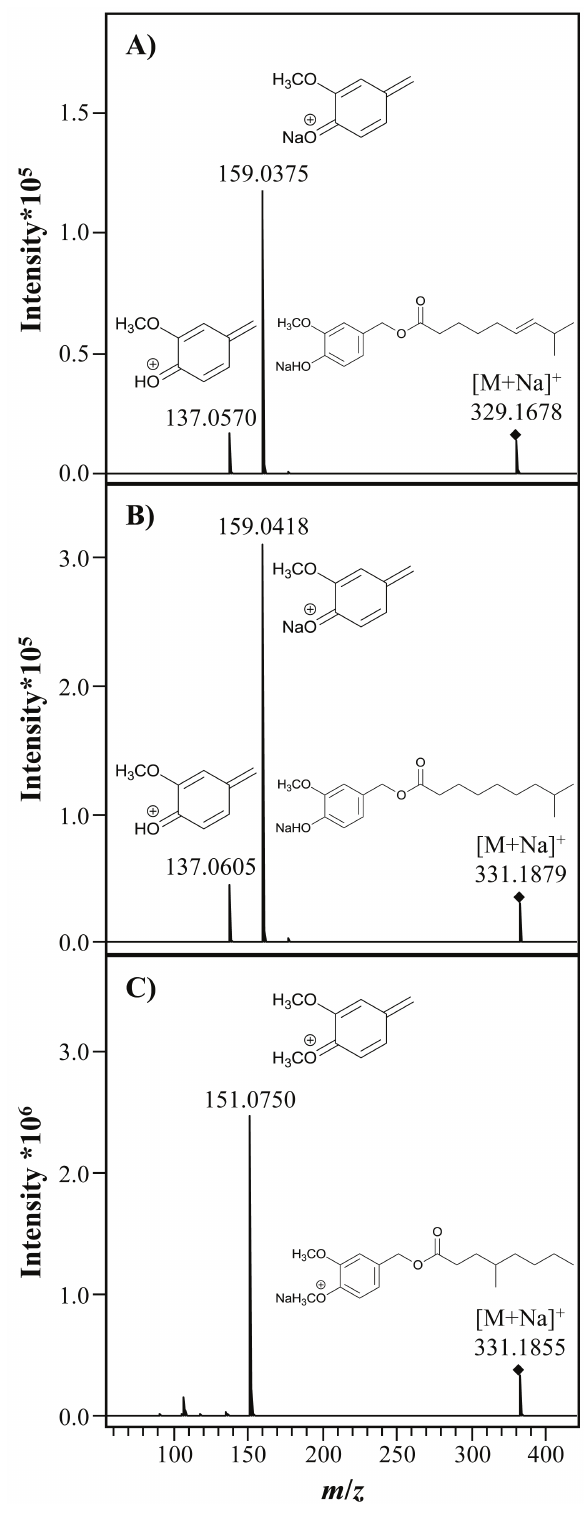
Figure 5: ESI-MS/MS spectra in positive ion mode of capsiate, dihydrocapsiate and (±)-DMBO. The individual standard solutions in 60% methanol of 10 µmol L -1 capsiate (A) and dihydrocapsiate (B), and 20 µmol L -1 (±)-DMBO (C) were acquired by direct injection on the QTOF mass